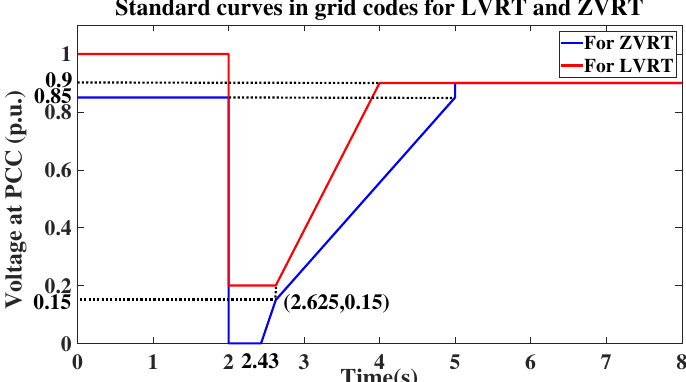
Figure A1. Standard curves in grid codes for LVRT and ZVRT. The LVRT and ZVRT curves shown using the grid codes for China and South Australia